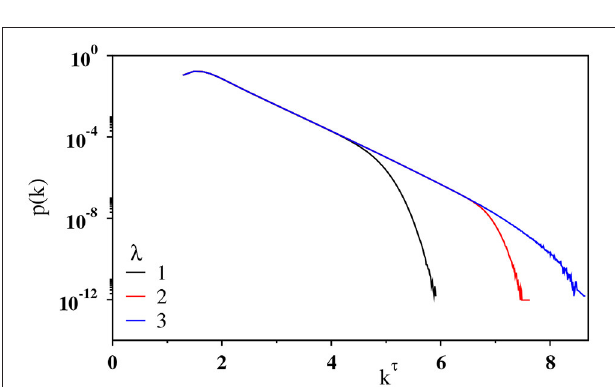
FIGURE 7 | Plot of the degree distribution p ( k ) against k τ with τ visibility graph associated with a random time series of N distributed data values on a semilog scale for λ = 1 (black), 2 (red), and 3